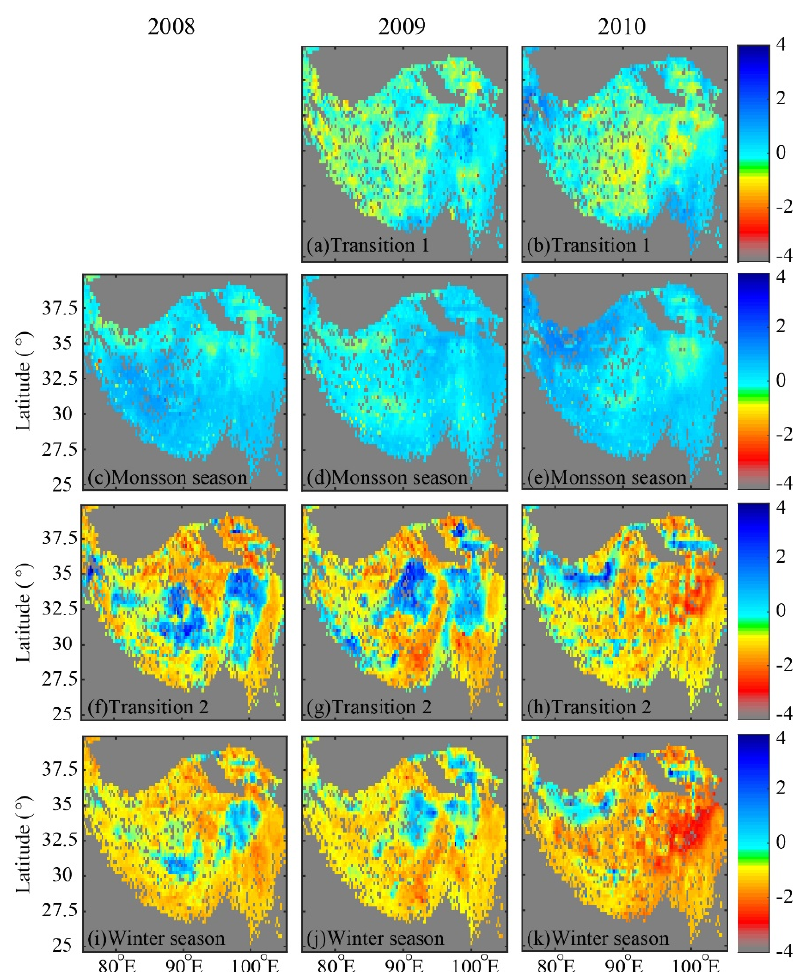
Figure 9. Seasonal variations of anomalies of the blended SM product over the TP for the blending period (1 May 2008–31 October 2010). ( a , b ) Transition 1 (April); ( c – e ) monsoon season (May–October); ( f , h ) Transition 2 (November); and ( i – k ) winter season (December–March).